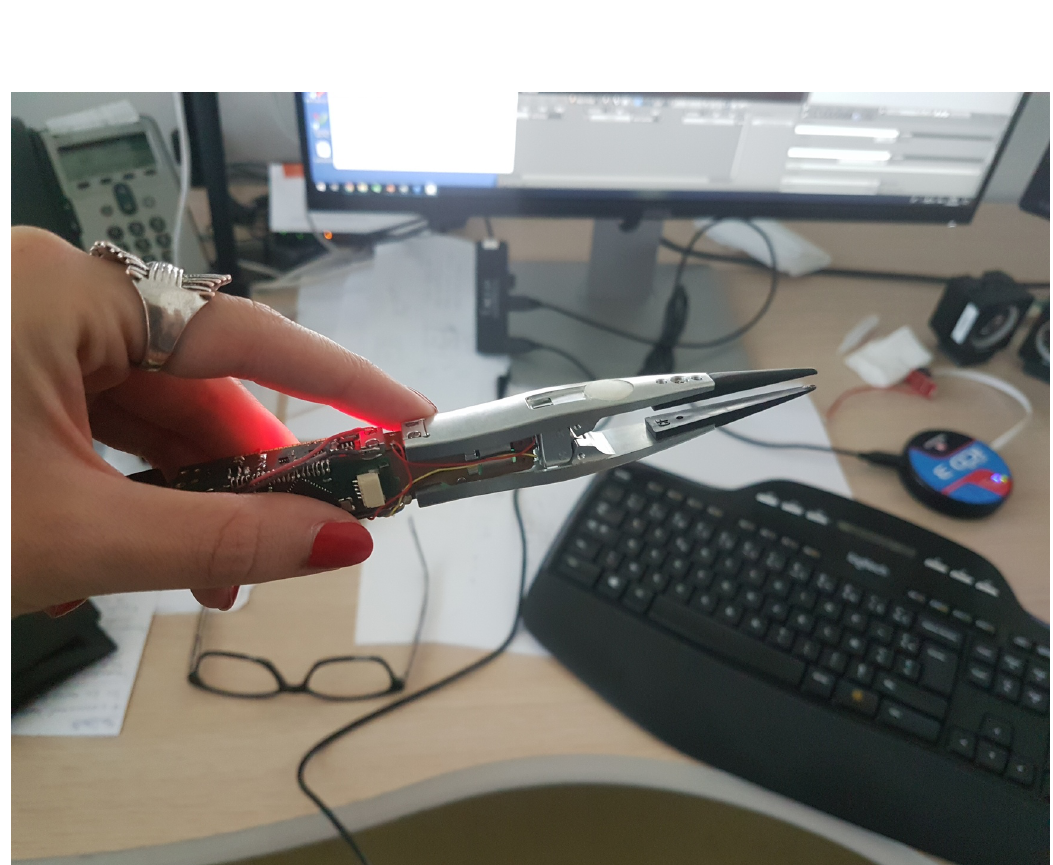
Fig. 3. The haptic tweezers. Picture was taken by the author at ISIR labs.